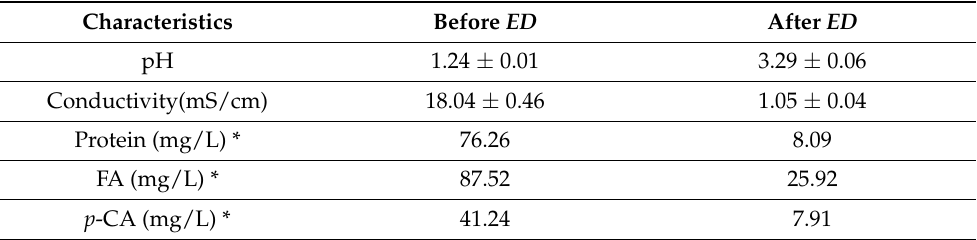
Table 4. Characteristics of the examined CAH liquor.